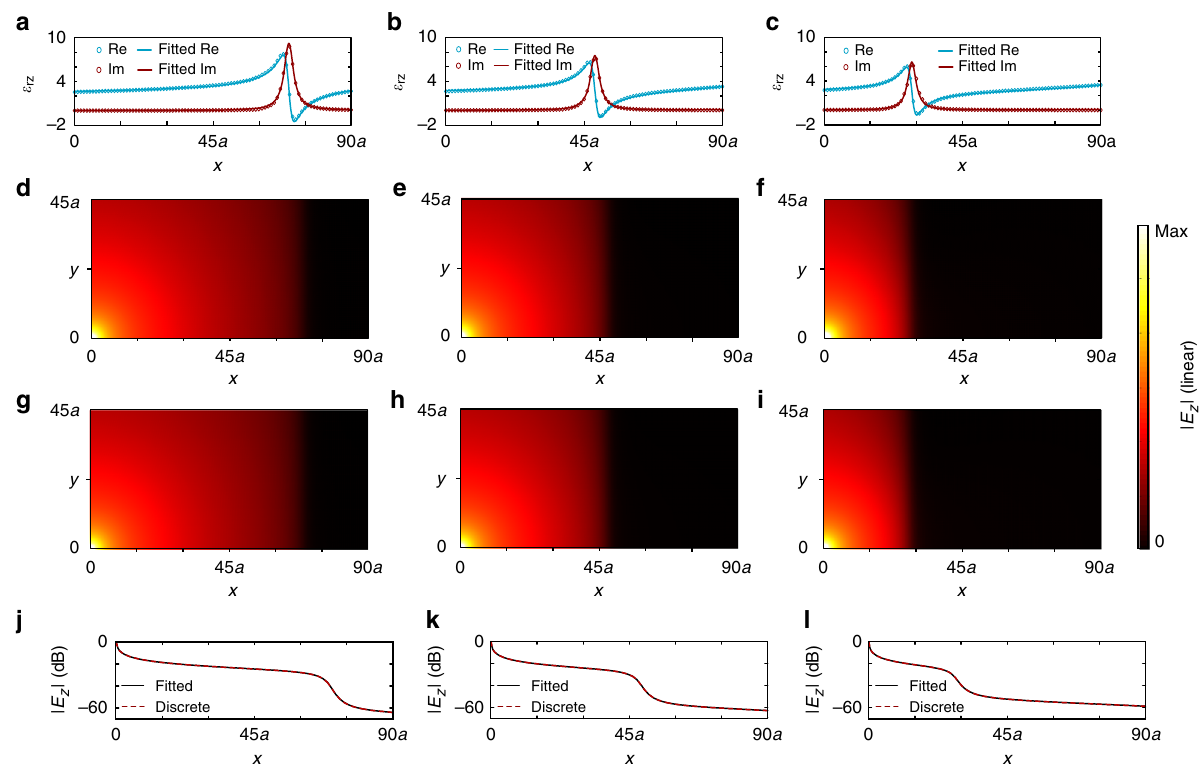
Fig. 4 Full-wave simulations to the designed one-dimensional inhomogeneous plate. The simulations are performed at 2.3, 2.4, and 2.5 GHz. a – c The discrete x -dependent Kramers – Kronig (K – K) pro fi les ( open circles ) and the corresponding fi tted continuous ones ( solid lines ) at 2.3, 2.4, and 2.5 GHz, respectively. d – f The simulated amplitudes of z -polarized electric fi elds when a line source is placed at the origin of the plate with the discrete K – K pro fi les. g – i The simulated amplitudes with the fi tted continuous K – K pro fi les. j – l The intensity drops in dB scale along the x axis at y = 0 for the discrete ( open circles ) and fi tted ( solid lines ) K – K permittivity pro fi les. Note that the same absolute color scale is used for all fi gures from d –